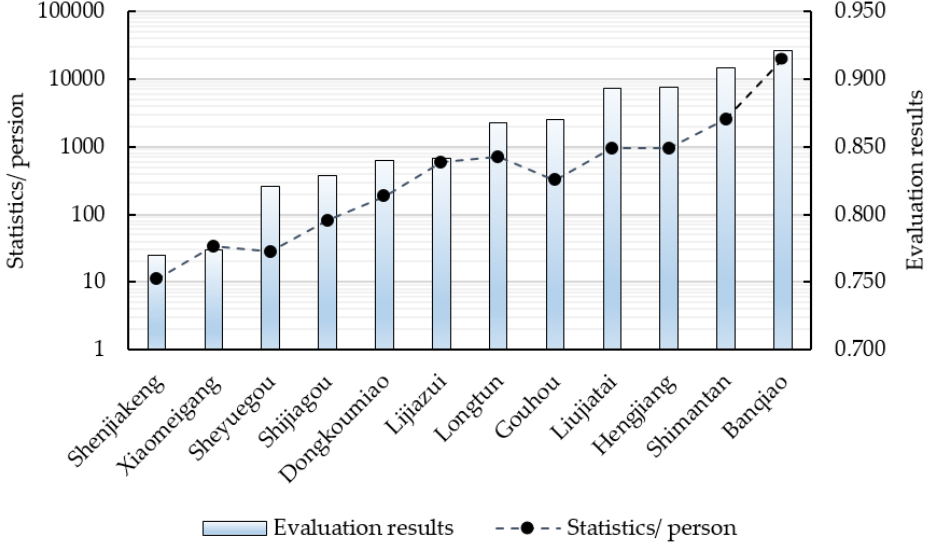
Figure 4. Evaluation results of dam breach of Jiangang Reservoir and some validation reservoirs.